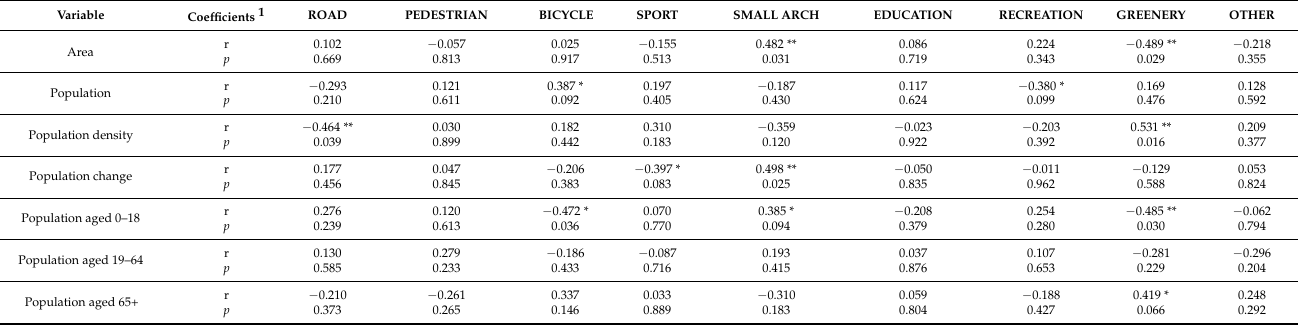
Table 2. A correlation table of the studied variables characterizing the districts of Cz ę stochowa.